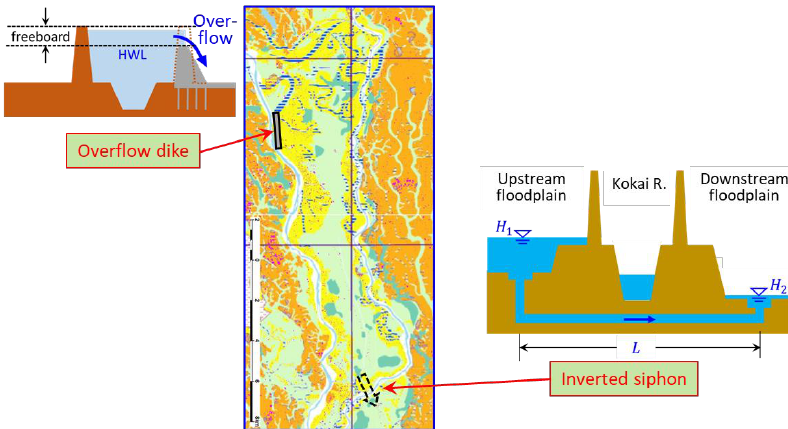
Figure 10. Application of RWRB to closed basin of Kinu River Floodplain.